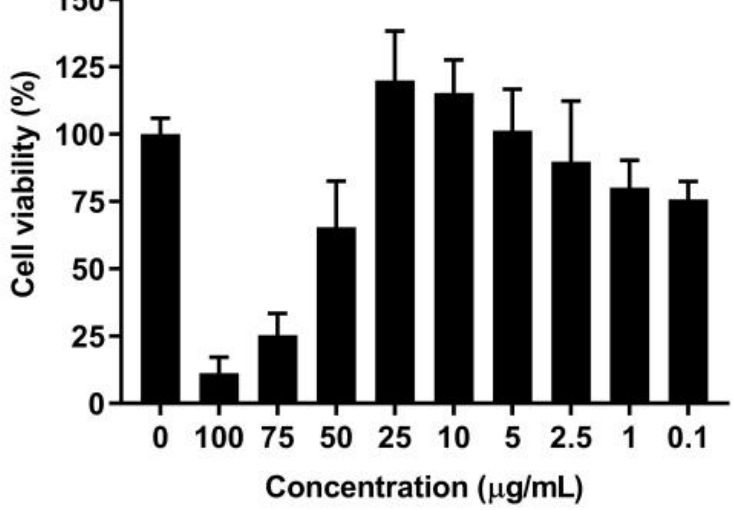
Figure 4. Effect of Maackia amurensis branch extract on CCD-986Sk cell viability. CCD-986sk cells were treated with various concentrations of M. amurensis branch extract. A. M. amurensis branch extract concentrations of >50 µg/mL showed cytotoxicity. B. M. amurensis branch extract showed no cytotoxicity at 37.5, 25, and 12.5 μg/mL concentrations. Data are presented as mean ± SD of three independent experiments.